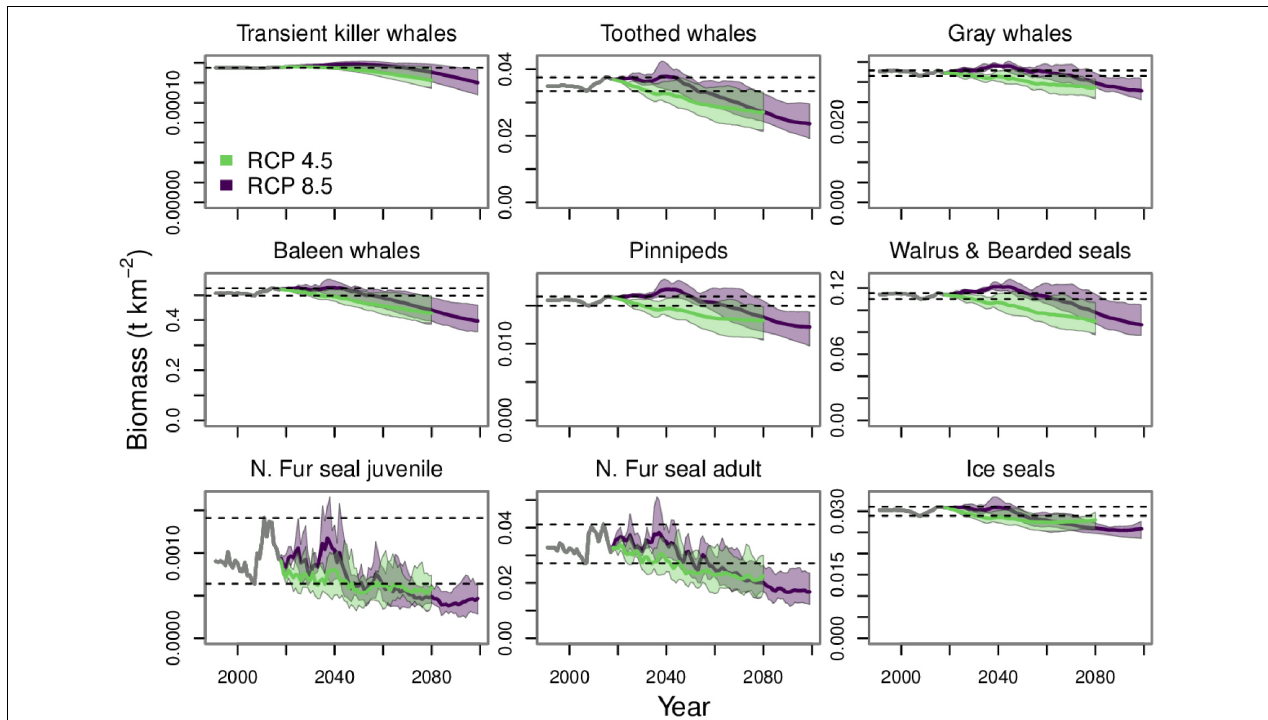
FIGURE 7 | Biomass projections for marine mammal functional groups. The gray line from 1991 to 2017 indicates the historical period. The purple and green polygons indicate the minimum and maximum range for the three earth system models run under each RCP. The purple and green lines indicate the mean of the three runs for each RCP. The dashed lines indicate the minimum and maximum values from the historical period.